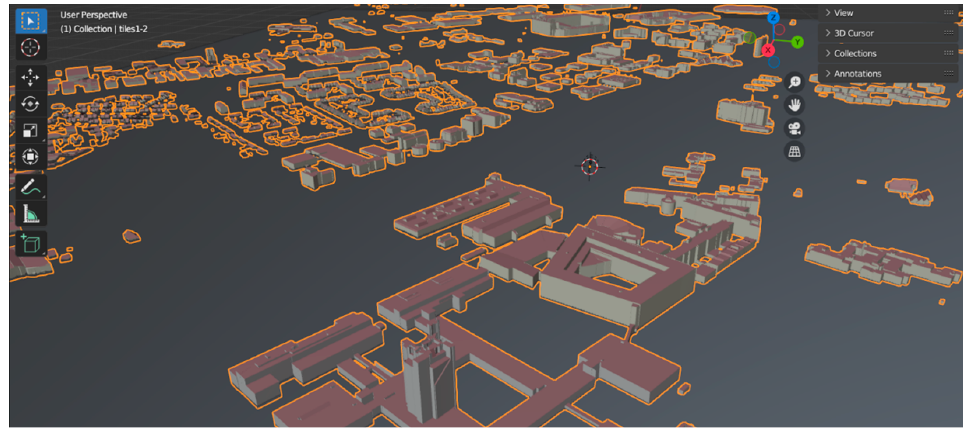
Figure 4. The 3D obj models of the neighborhood’s buildings loaded from the 3D BAG dataset.